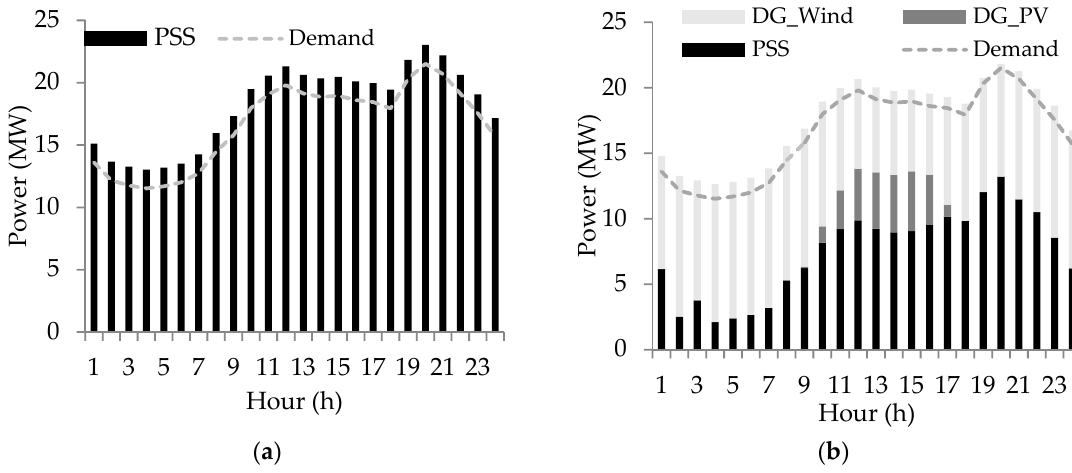
Figure 3. Energy mixes in the ( a ) Base Case and ( b ) Case B. PSS: Power from Substation; DG: distributed generation.